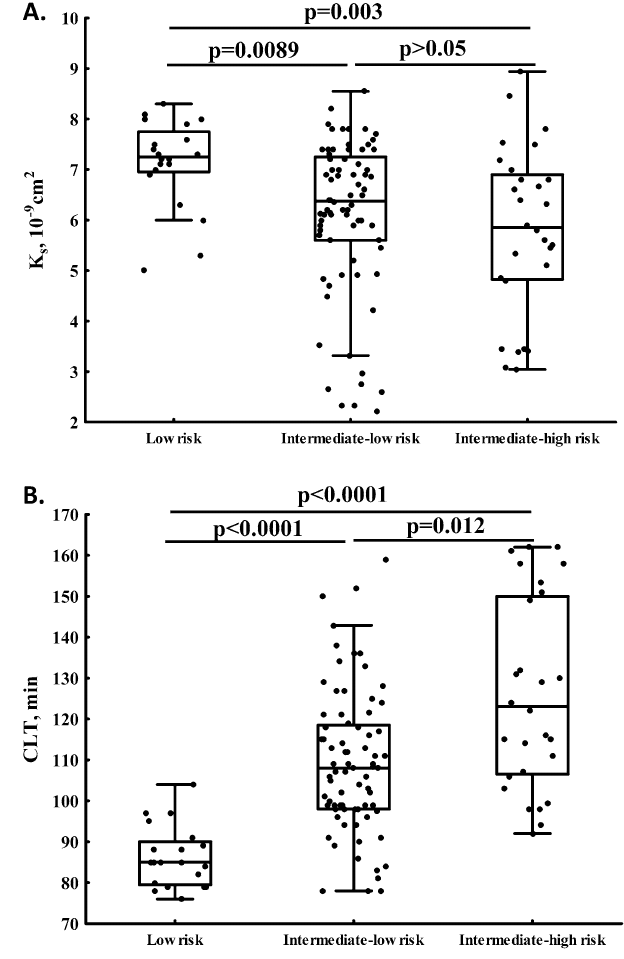
Figure 1. Fibrin clot permeability (K s , A ) and clot lysis time (CLT, B ) determined in acute PE patients with low, intermediate-low, and intermediate-high early mortality risk (both p < 0.05 for